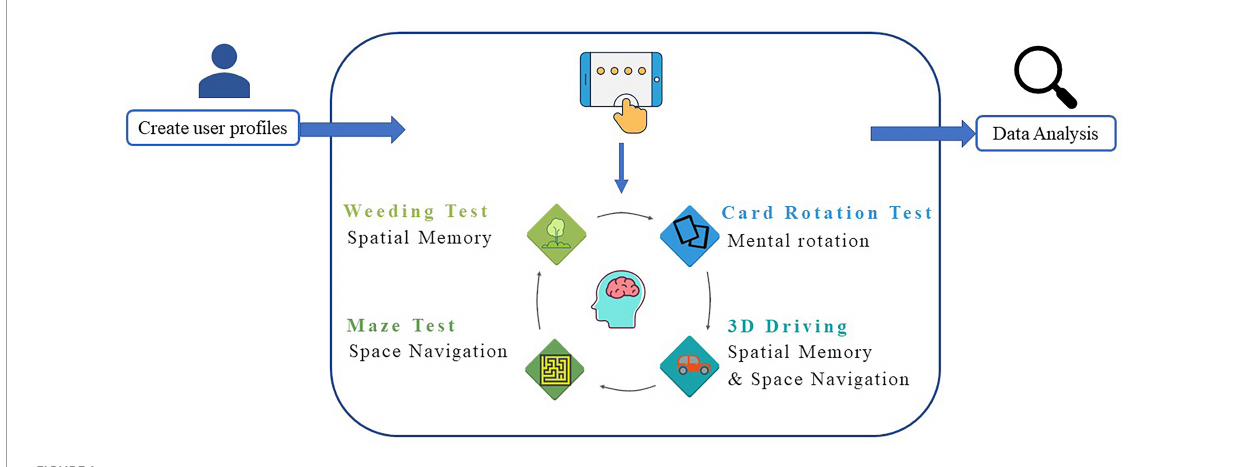
FIGURE1 Vestibular cognitive assessment system (VCAS) frame. The system includes three main sections: Information input, test, and result query.